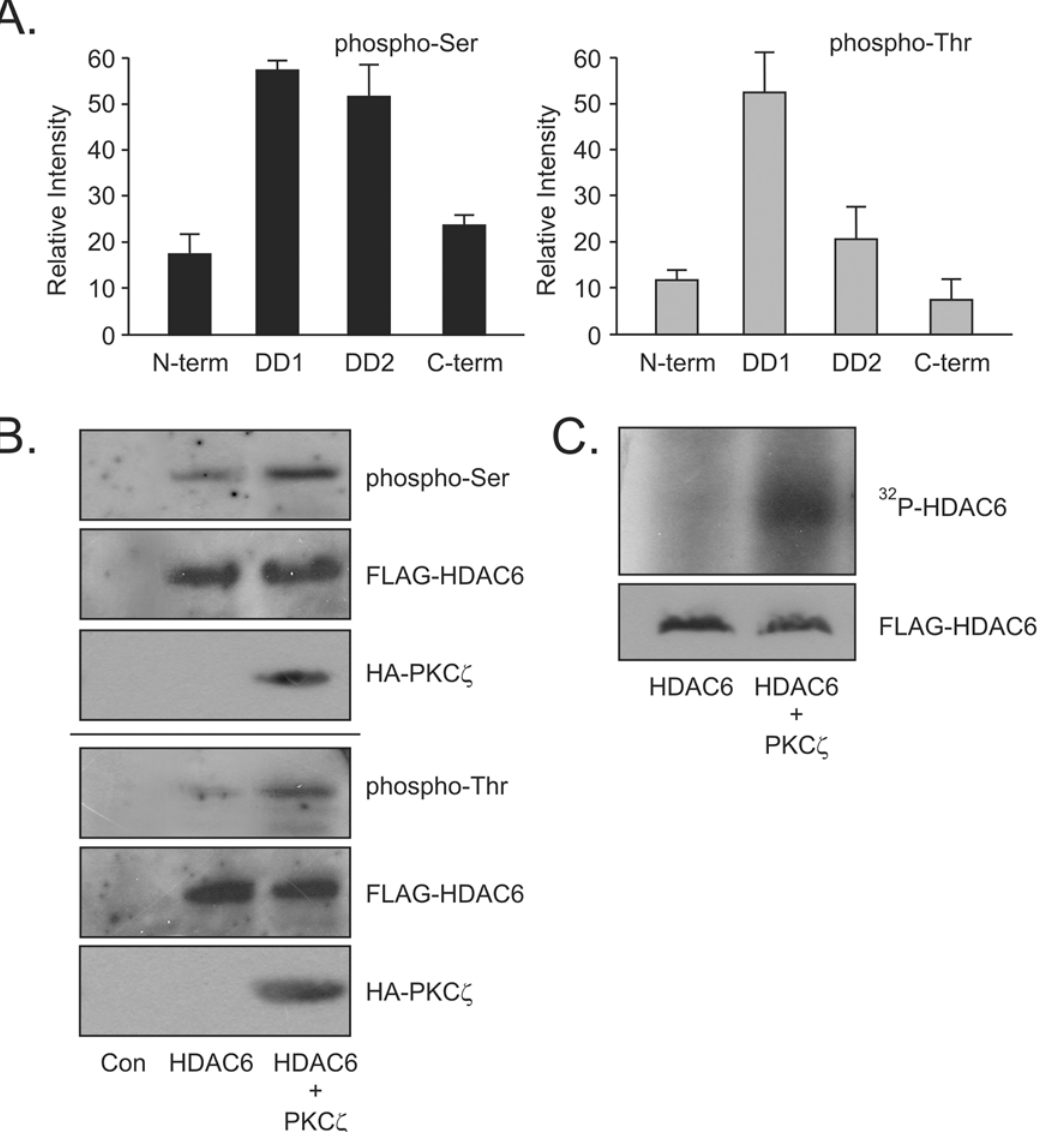
Fig 2. Atypical PKC ζ phosphorylates HDAC6. ( A ) GST-deletion constructs of HDAC6 were expressed in HEK cells and captured by GST-pulldown assay. Purified PKC ζ enzyme was used to catalyze an in-vitro phosphorylation assay using the GST-deletion constructs as substrate. Phosphorylation of each construct was assessed using SDS-PAGE and phospho-specific antibodies for phospho-Serine and phospho-Threonine. Relative changes in phosphorylation were measured by densitometry and analyzed using UN-SCAN-IT 6.1 Software (Orem, UT). ( B ) FLAG-HDAC6 was expressed in HEK cells either with or without HA-PKC ζ expression. In vivo phosphorylation increases were detected using phospho-specific antibodies. ( C ) FLAG-HDAC6 was expressed in HEK cells and immunoprecipitated with anti-FLAG antibody. The immunoprecipitate was used as a substrate in an immune-complex kinase assay with purified PKC ζ enzyme as the catalyst. Changes in phosphorylation were detected by incorporation of 32 P-ATP and autoradiography. All results are indicative of 3 independent